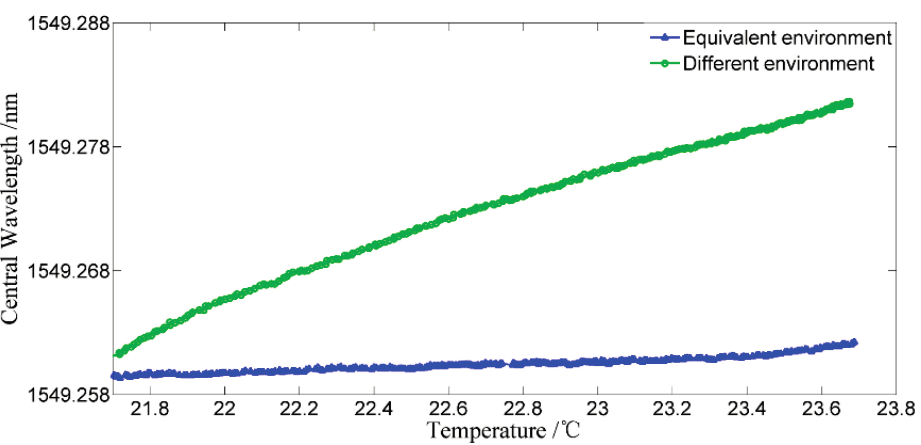
Figure 16. Experimental results of the anti-temperature perturbation performance of the interrogation